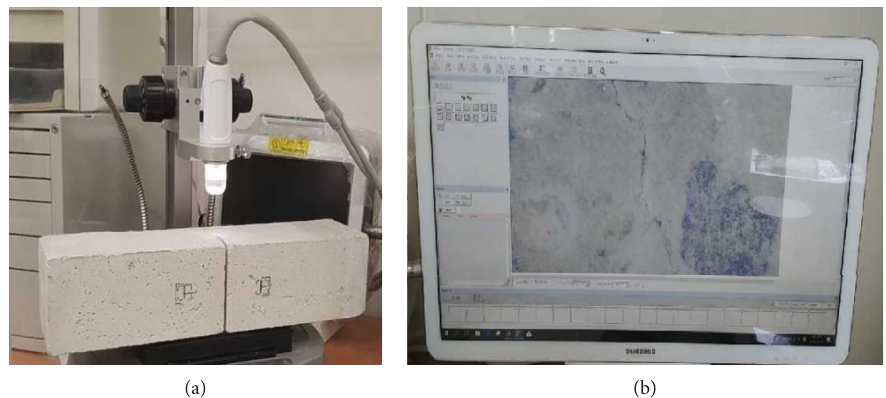
Figure 2: Microscope setup used to image cracked specimens before and after healing: (a) microscope equipped with a digital camera; (b) image capture.